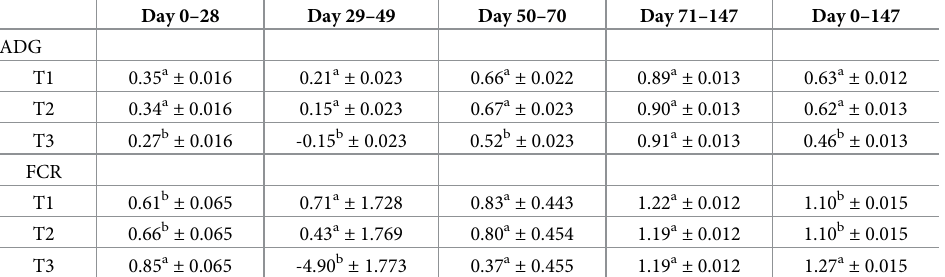
Table 2. Average daily gain and feed conversion ratio (FCR) by production phase and treatment group. Data are presented as the LSmean ± SEM. Removal weights were not added back into the pen weight for the ADG and FCR